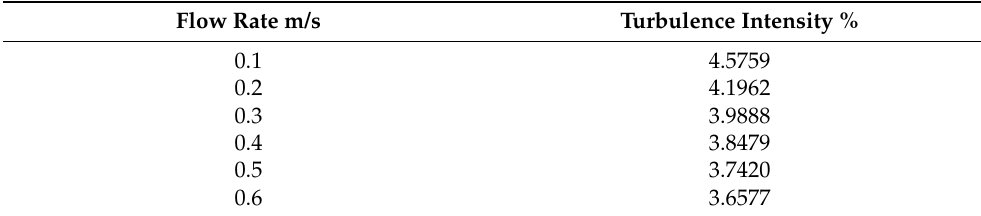
Table 7. Valve inlet conditions parameters table.